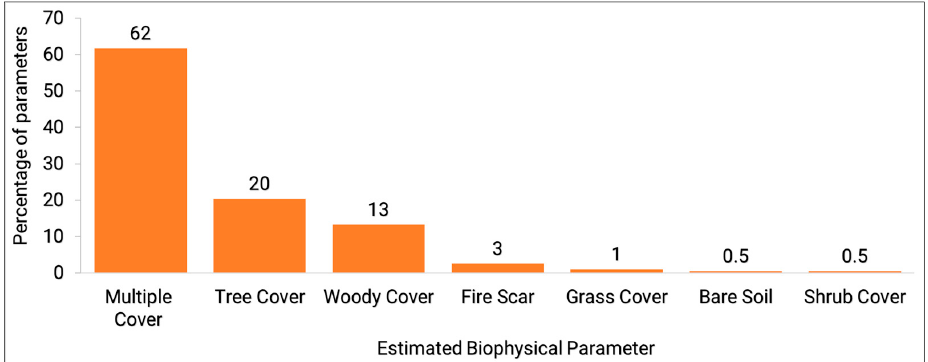
Figure 5. Biophysical parameters estimated.